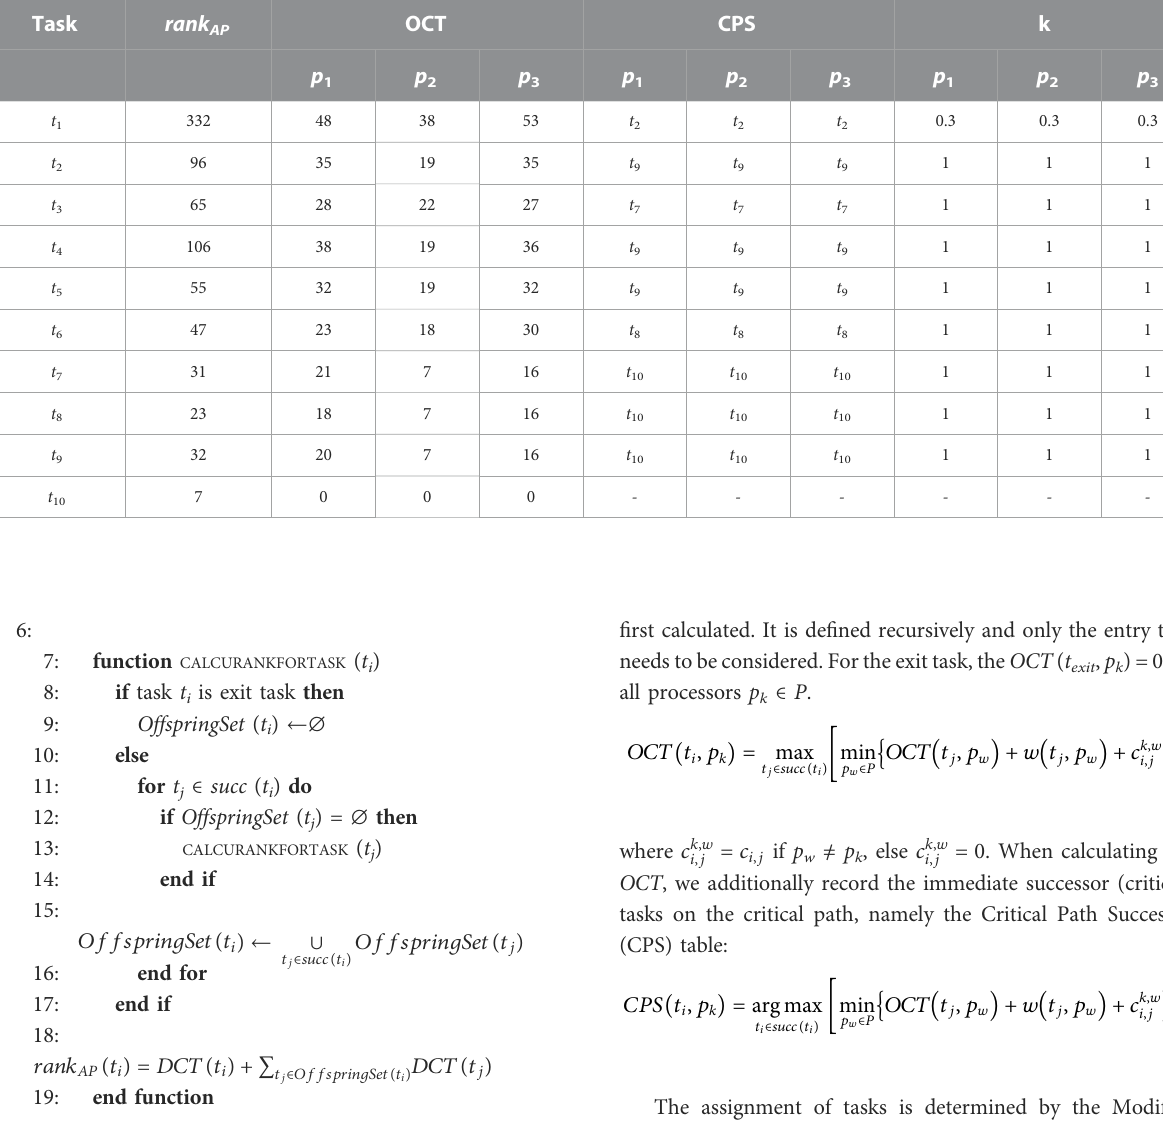
TABLE 3 Produced by Processor Selection Phase on the sample DAG in Figure 2 Task rank